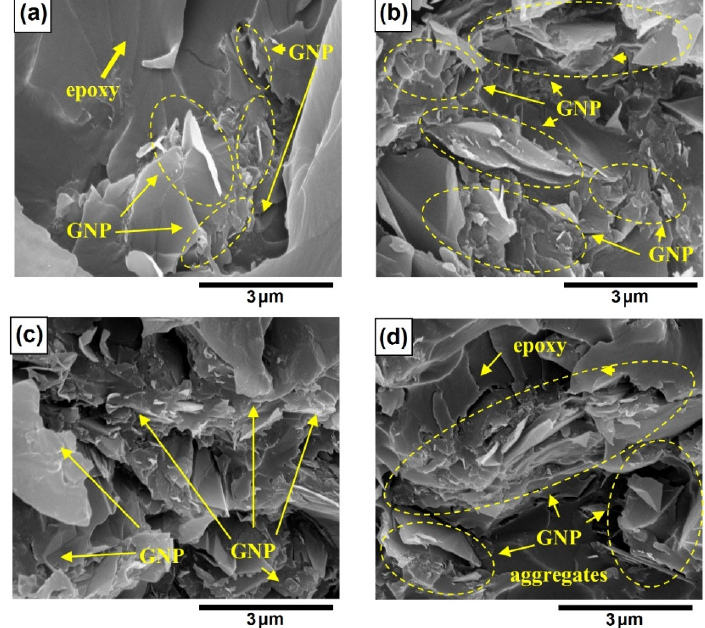
Figure 4. SEM of fracture surface of GNP (C-300 series) in epoxy at loadings of ( a ) f GNP = 1.0 wt %; ( b ) f GNP = 2.0 wt %; ( c ) f GNP = 10 wt %; ( d ) f GNP = 20.0 wt